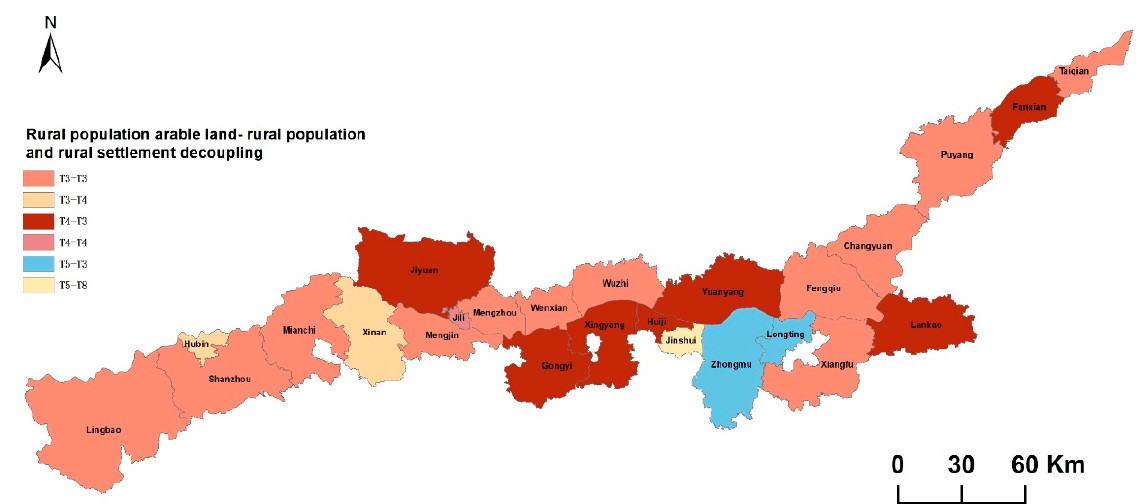
Figure 7. Combination decoupling types of the rural population, arable land, and rural settle- ments.